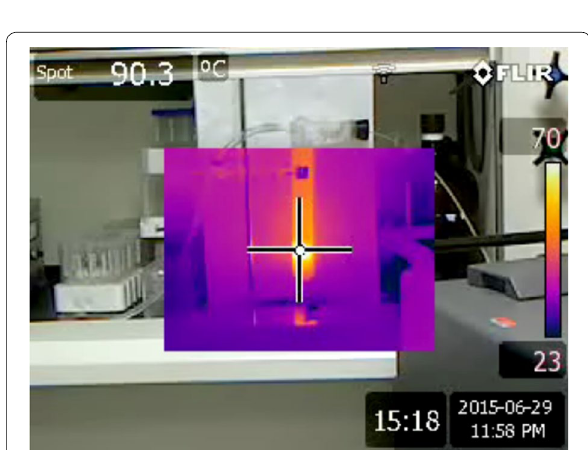
Fig. 3 Picture-in-picture thermal imaging of the tube reactor during biochar ozonization with its temperature scale (23–70 °C) displayed on the far right side. The experiment began with introduction of ozone gas into the reactor containing 50 g of biochar at ambient temperature (23 °C). As ozone reacted with biochar, the reactor got warmer. The top left value of 90.3 °C denotes the temperature recorded at the biochar reactor hot spot, as pointed by the cursor after 10-min treatment with ozone (recording time